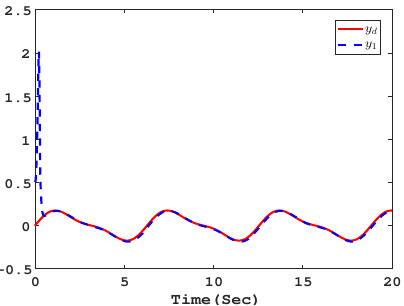
Figure 3. The system’s output y 1 and reference signal y d .